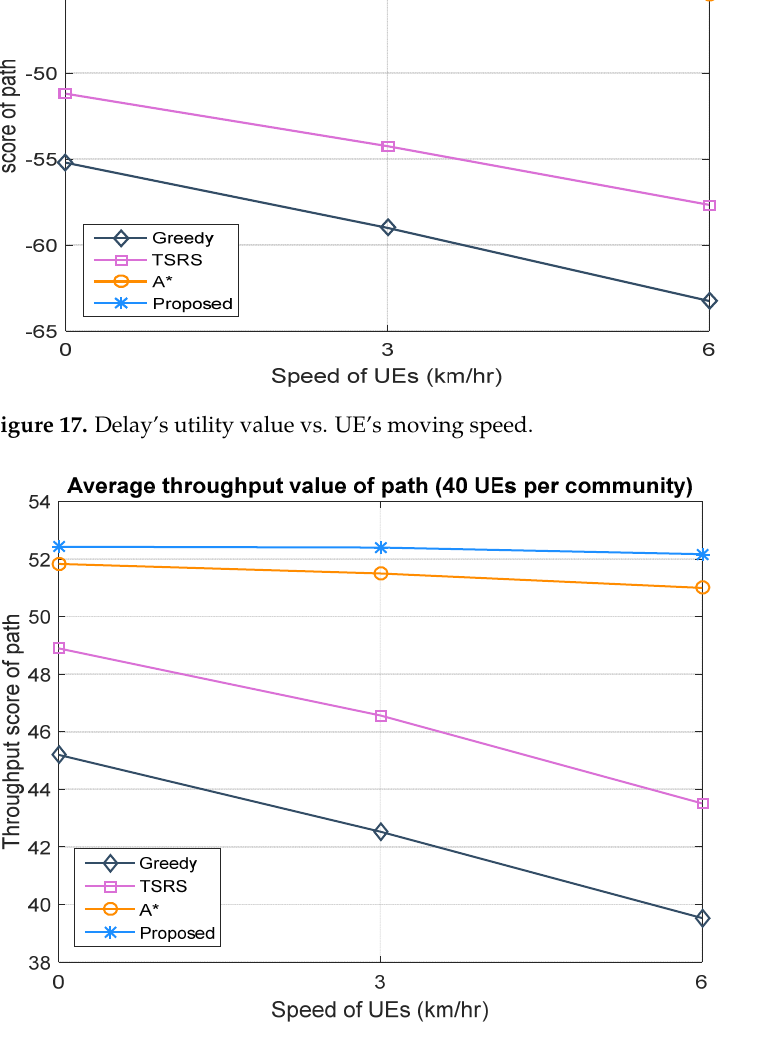
Figure 18. Throughput’s utility value vs. UE’s moving speed.